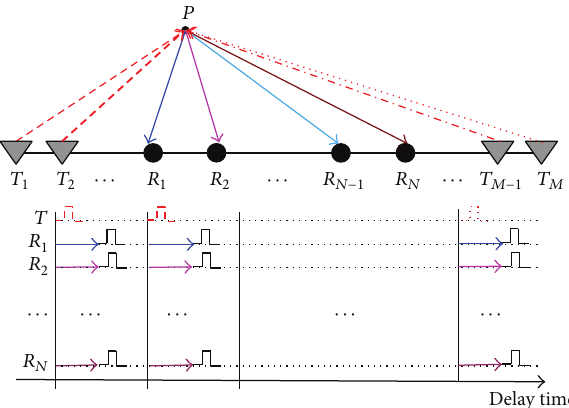
Figure2:Transmittingandreceivingorderofdown-lookingMIMO array